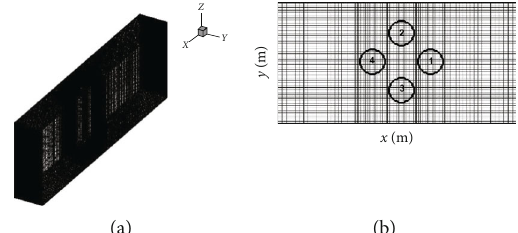
Figure 2: The grid of computational domain for the diamond arrangement of the four circular cylinders; (a) side view; (b) top view of the grid details around the cylinders by cut-cell